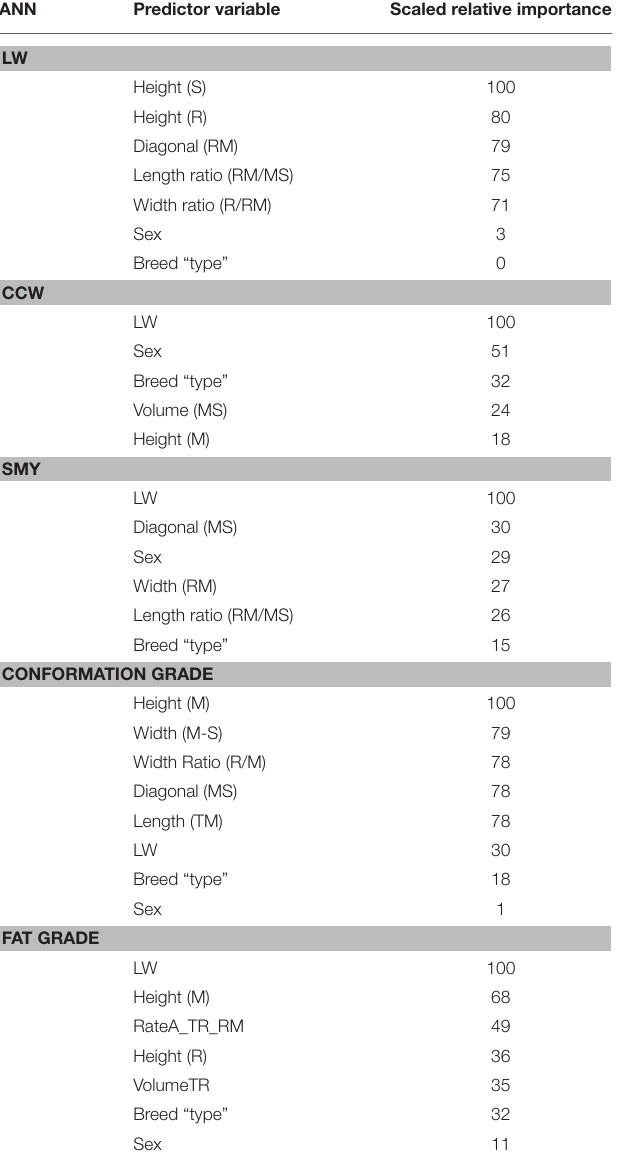
developed for fat and conformation grade using the abbreviated EUROP scale in operation at the abattoir. The accuracy of the classification ANNs for the validation data subset were 54.2% for fat grade and 55.1% for conformation grade. The confusion matrices are shown for the fat ( Table 4 ) and conformation grades ( Table 5 ), along with the sensitivity (ability of the model to correctly classify a data point to that particular grade) and specificity (ability of the model to correctly identify a